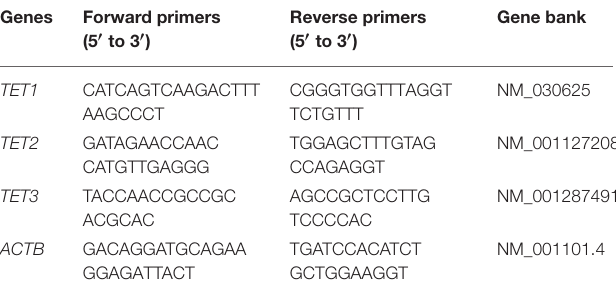
TABLE 1 | Sequences of primers (5 ′ to 3 ′ ) used in the real-time PCR for the detection of TET1 , TET2 , TET3 and the control gene ACTB ( β -actin gene). Genes Forward primers (5 ′ to 3 ′ )